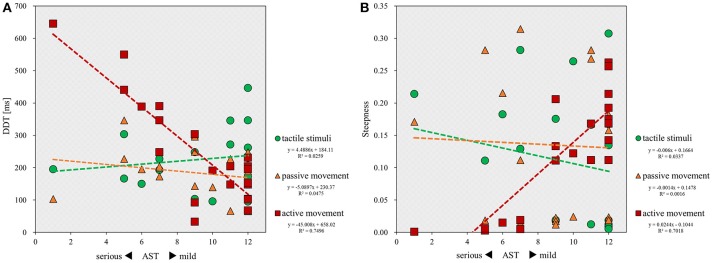
Scatterplot showing the relationship between the severity of apraxia and DDT or steepness for all patients in each stimulus condition. DDT, the delay detection threshold for the detection of delayed visual feedback. Steepness, the steepness of the probability curve for the detection of delayed visual feedback. The horizontal axis shows the AST score for the severity of apraxia. (A) Correlation between the severity of apraxia and the DDT of each stimulus condition (n = 22). (B) Correlation between the severity of apraxia and the steepness of each stimulus condition (n = 22).